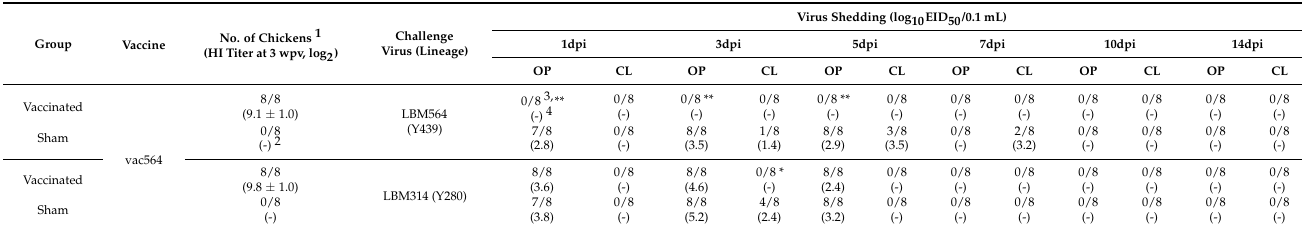
Table 3. Virus shedding by vaccinated SPF chickens challenged with Y439 and Y280 lineage H9N2 viruses (vac564).